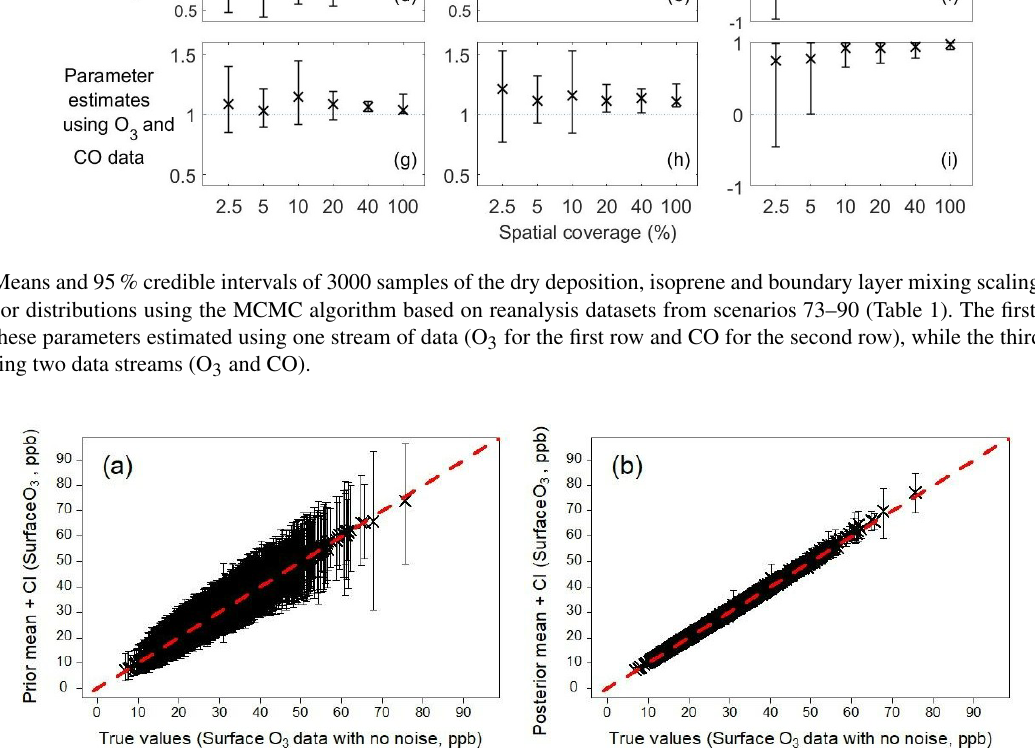
Figure 11. Emulator predictions of surface O 3 , evaluated at values of the scaling parameters sampled from the prior distribution (a) and posterior distribution (b) , showing the effects of calibration. In panel (b) , the outputs correspond to the scenario where the calibration involved synthetic O 3 data, a representation error of p = 0 . 2and a spatial coverage of 20% (Table 2). The predictions shown here are carried out for all model grid boxes, i.e. 100% spatial